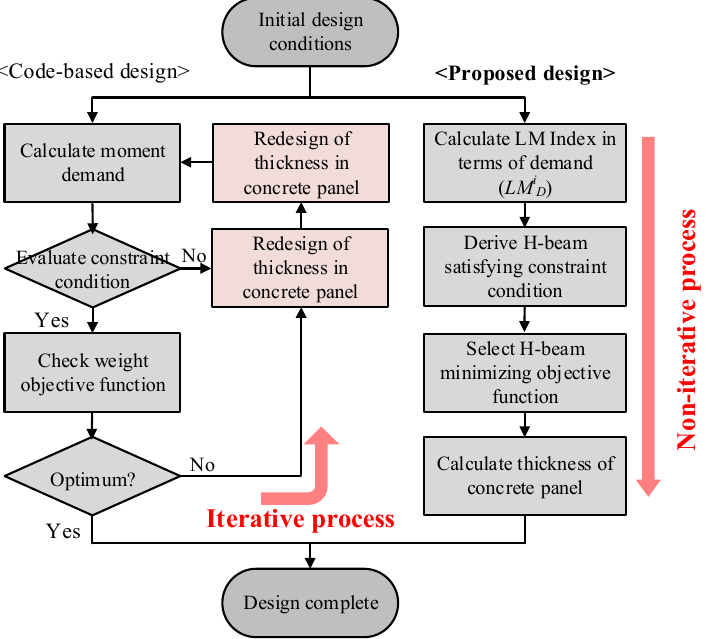
Figure 3. Comparison of optimization processes between code-based design and proposed optimal design methods.